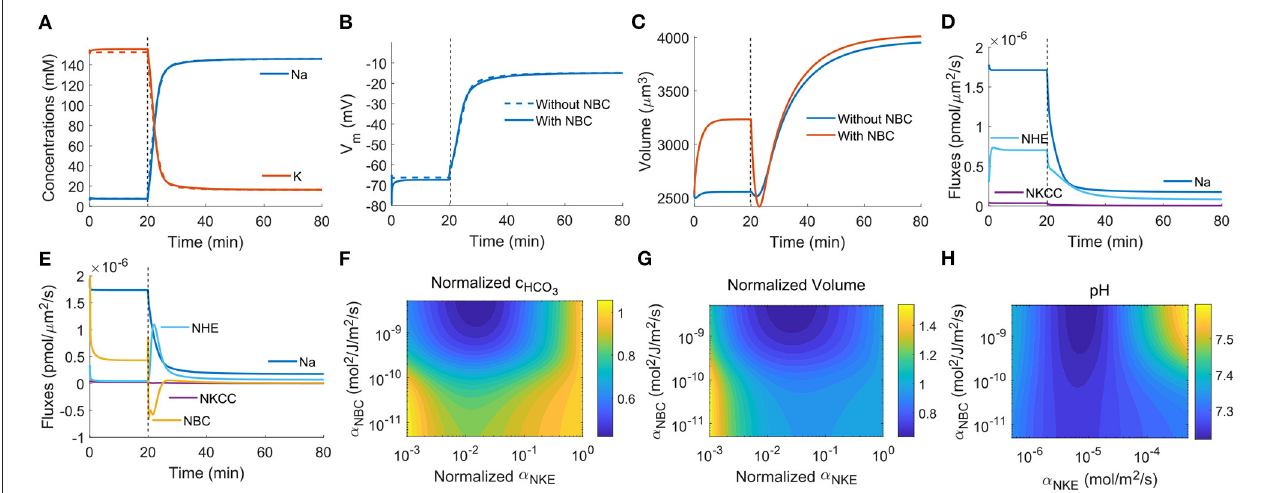
FIGURE 7 | Model predictions of the cellular response upon NKE inhibition applied at t 0 = 20 min (indicated by dashed vertical lines) by reducing α NKE by three orders of magnitude. (A) Intracellular Na + and K + concentrations. Dashed lines: without NBC. Solid lines: with NBC. (B) Cell membrane potentials. (C) Cell volumes. (D) Fluxes across the channels, transporters, and pumps that transport Na + . NBC is absent. (E) Fluxes across the channels, transporters, and pumps that transport Na + . NBC is present. (F) Contour plot of the steady-state, normalized intracellular HCO − 3 concentration as a function of the permeability coefficient of NBC and the normalized permeability coefficient of NKE. α NKE indicates the degree of NKE activity. The concentration of HCO − 3 is normalized with respect to the case without NKE inhibition so that the vertical line on the right end of the contour has value 1. (G) Contour plot of the steady-state, normalized cell volume as a function of the permeability coefficient of NBC and the normalized permeability coefficient of NKE. (H) Contour plot of the steady-state intracellular pH as a function of the permeability coefficients of NBC and